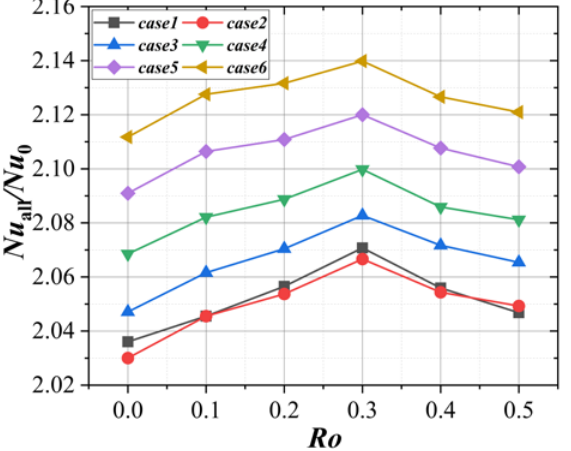
Figure 19. The variation of Nu all /Nu 0 with Ro for different channels.